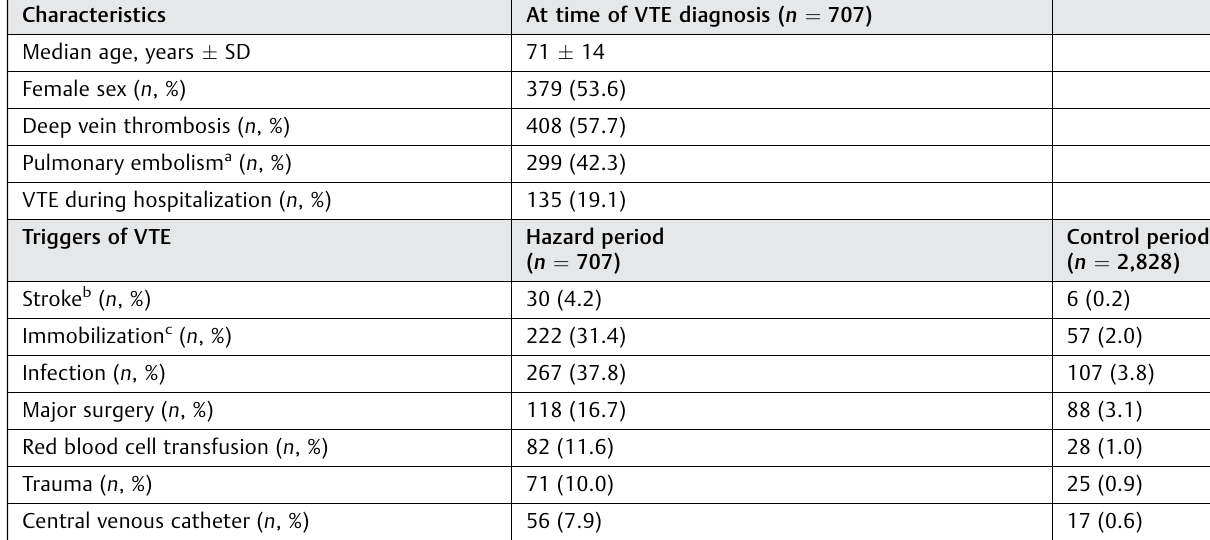
Table 1 Characteristics of the study participants Characteristics At time of VTE diagnosis ( n ¼ 707)